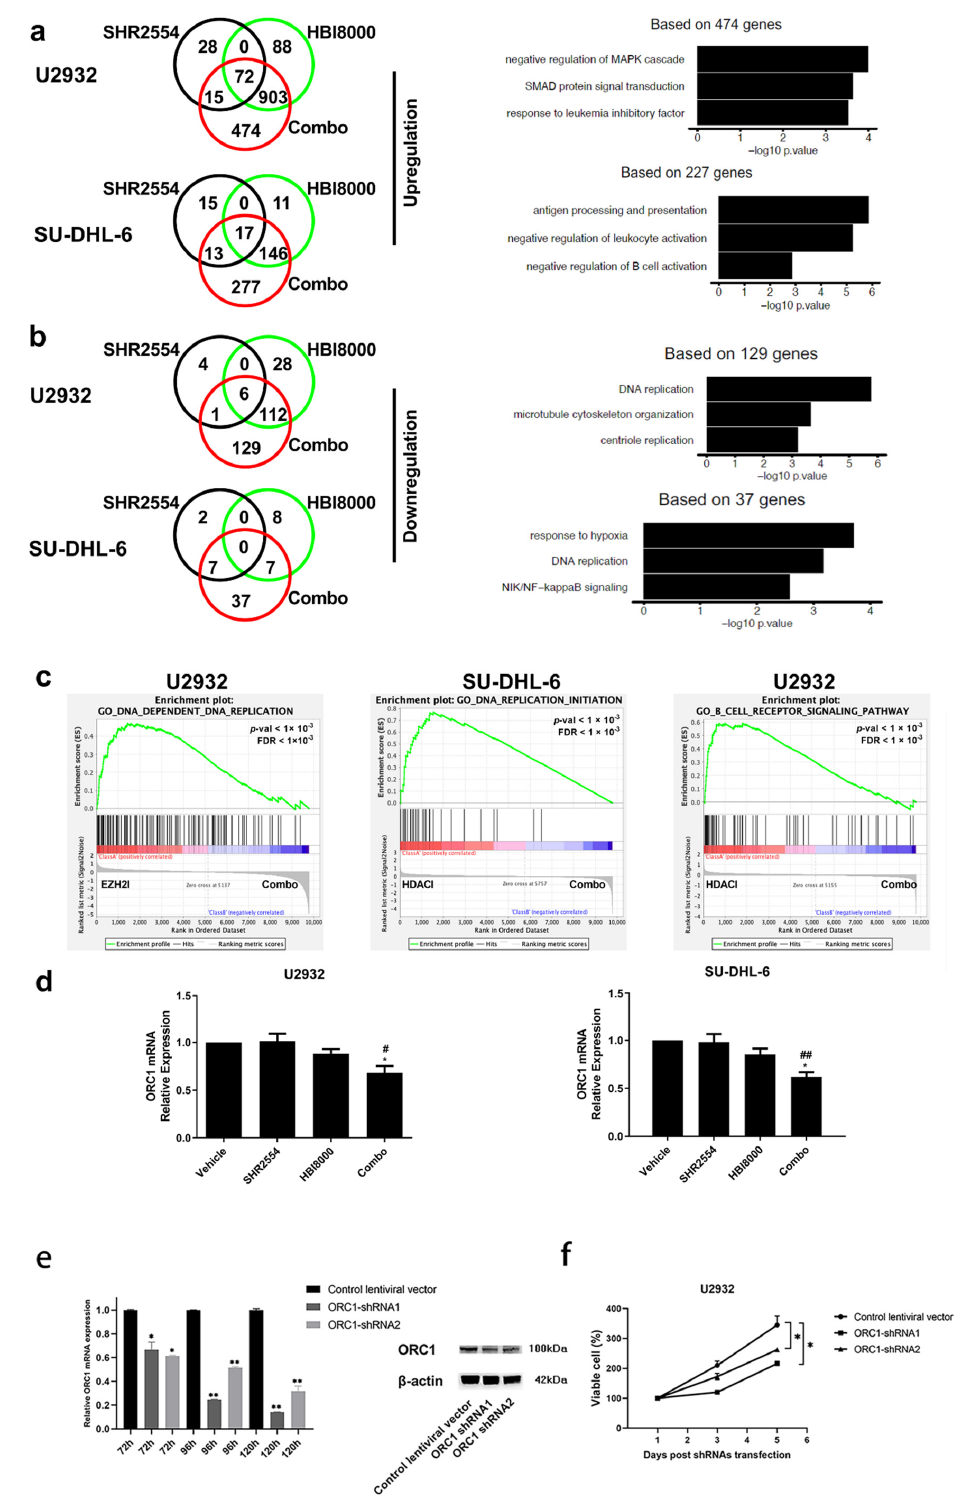
Figure 4. Gene expression signatures in DLBCL are affected by combination treatment of SHR2554 with HBI8000.